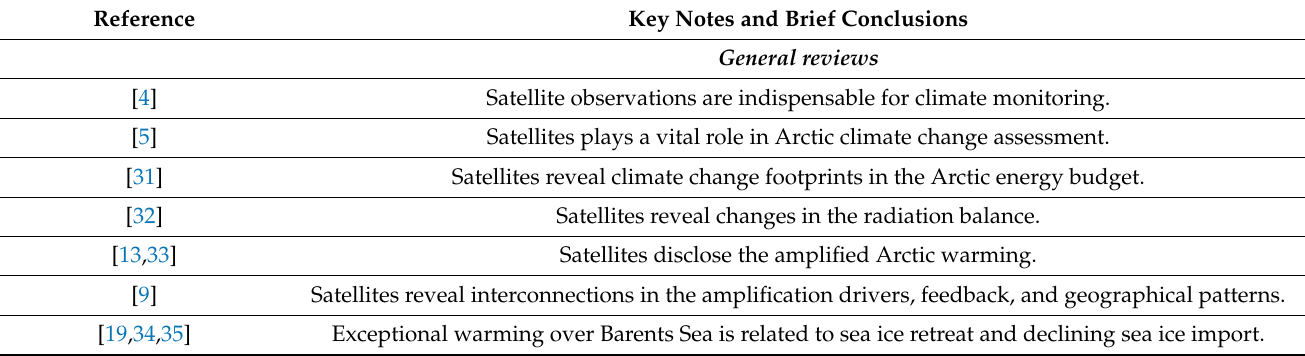
Table 1. List of key recent reviews focusing on satellite observations of Arctic climate